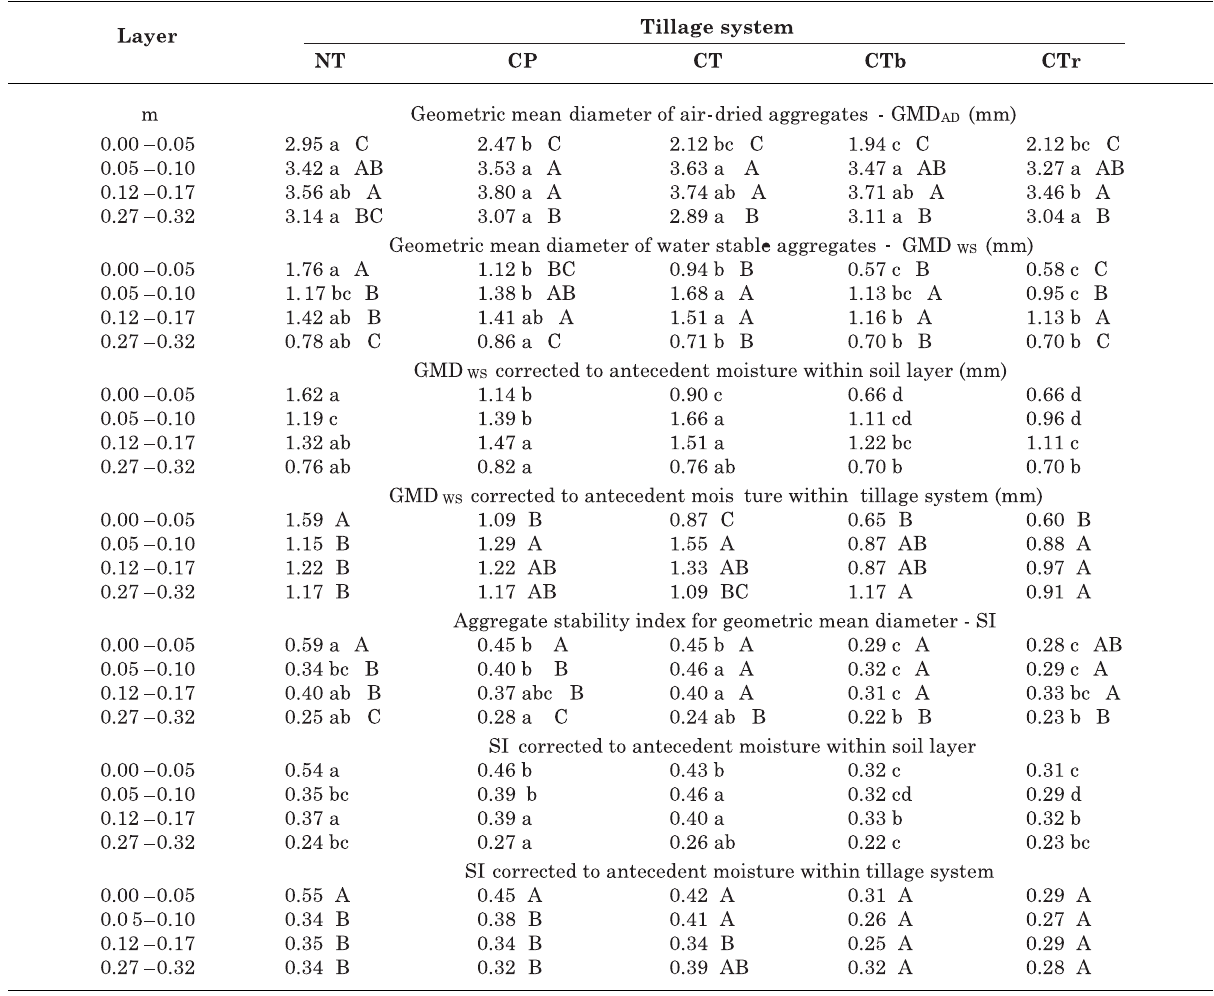
Table 4. Size distribution and aggregate stability indexes in four layers, after nine years under five tillage systems (averaged across nutrient